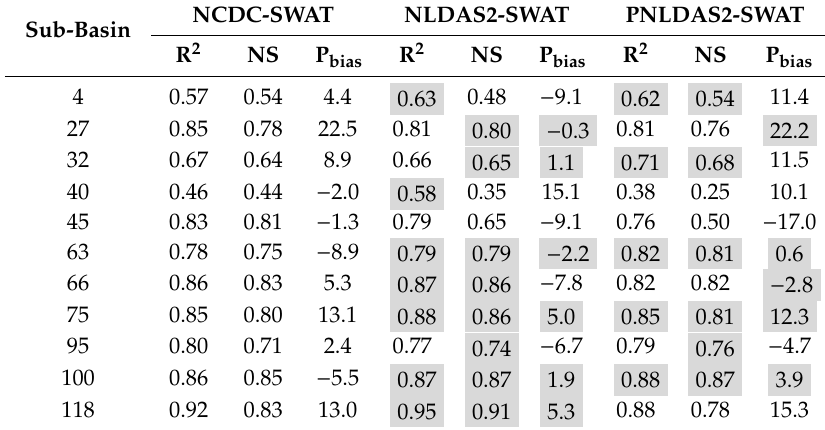
Table 4. Model performance on monthly stream flow at 11 monitoring stations in three scenarios during